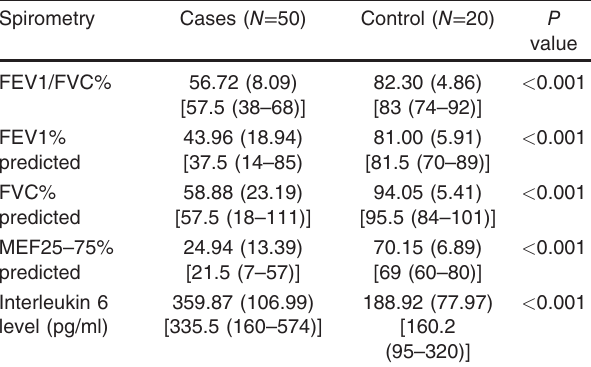
Table 2 Spirometric data and serum interleukin 6 level among patients with chronic obstructive pulmonary disease and